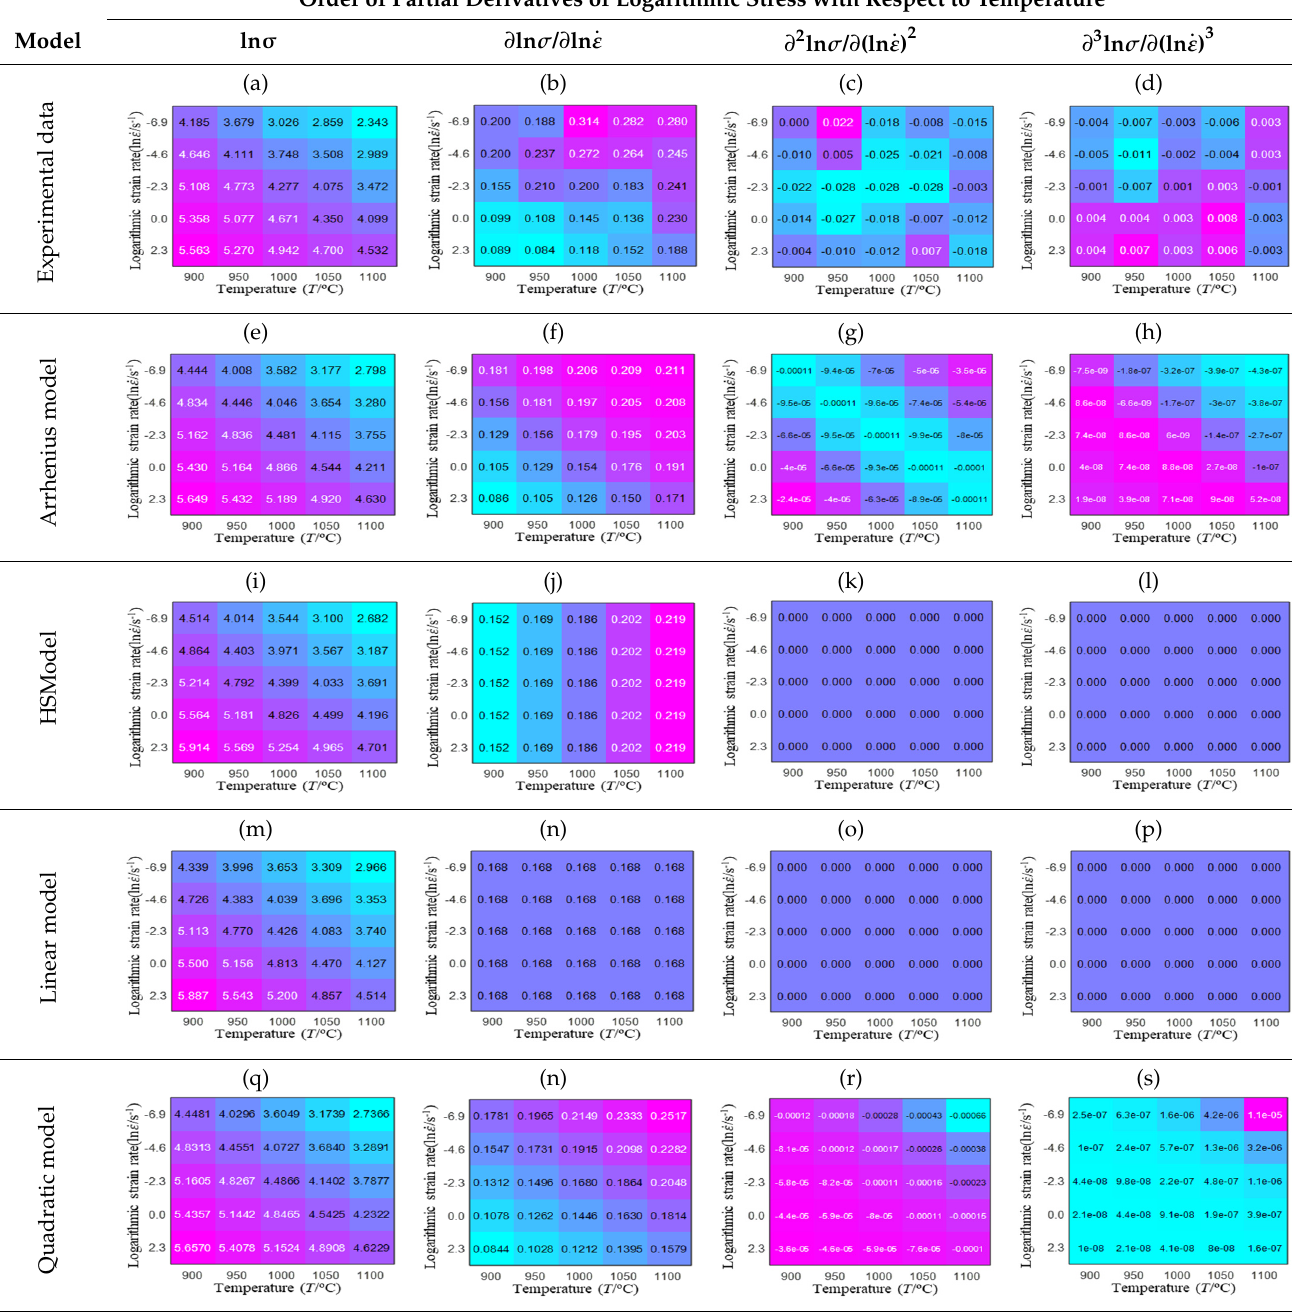
Table 9. The first, second and third partial derivatives of logarithmic stress with respect to strain rate Table 9. The fi rst, second and third partial derivatives of logarithmic stress with respect to strain Table 9. The fi rst, second and third partial derivatives of logarithmic stress with respect to strain Table 9. The fi rst, second and third partial derivatives of logarithmic stress with respect to strain Table 9. The fi rst, second and third partial derivatives of logarithmic stress with respect to strain Table 9. The fi rst, second and third partial derivatives of logarithmic stress with respect to strain Table 9. The fi rst, second and third partial derivatives of logarithmic stress with respect to strain Table 9. The fi rst, second and third partial derivatives of logarithmic stress with respect to strain for different models at ε = 0.04. Table 9. The fi rst, second and third partial derivatives of logarithmic stress with respect to strain Table 9. The fi rst, second and third partial derivatives of logarithmic stress with respect to strain Table 9. The fi rst, second and third partial derivatives of logarithmic stress with respect to strain Table 9. The fi rst, second and third partial derivatives of logarithmic stress with respect to strain Table 9. The fi rst, second and third partial derivatives of logarithmic stress with respect to strain Table 9. The fi rst, second and third partial derivatives of logarithmic stress with respect to strain Table 9. The fi rst, second and third partial derivatives of logarithmic stress with respect to strain Table 9. The fi rst, second and third partial derivatives of logarithmic stress with respect to strain Table 9. The fi rst, second and third partial derivatives of logarithmic stress with respect to strain Table 9. The fi rst, second and third partial derivatives of logarithmic stress with respect to strain Table 9. The fi rst, second and third partial derivatives of logarithmic stress with respect to strain Table 9. The fi rst, second and third partial derivatives of logarithmic stress with respect to strain Table 9. The fi rst, second and third partial derivatives of logarithmic stress with respect to strain rate for di ff erent models at 𝜀 = 0.04 . rate for di ff erent models at 𝜀 = 0.04 . rate for di ff erent models at 𝜀 = 0.04 . rate for di ff erent models at 𝜀 = 0.04 . rate for di ff erent models at 𝜀 = 0.04 . rate for di ff erent models at 𝜀 = 0.04 . rate for di ff erent models at 𝜀 = 0.04 . rate for di ff erent models at 𝜀 = 0.04 . rate for di ff erent models at 𝜀 = 0.04 . rate for di ff erent models at 𝜀 = 0.04 . rate for di ff erent models at 𝜀 = 0.04 . rate for di ff erent models at 𝜀 = 0.04 . rate for di ff erent models at 𝜀 = 0.04 . rate for di ff erent models at 𝜀 = 0.04 . rate for di ff erent models at 𝜀 = 0.04 . rate for di ff erent models at 𝜀 = 0.04 . rate for di ff erent models at 𝜀 = 0.04 . rate for di ff erent models at 𝜀 = 0.04 . rate for di ff erent models at 𝜀 = 0.04 . rate for di ff erent models at 𝜀 = 0.04 . . Order of Partial Derivatives of Logarithmic Stress with Respect to Temperature . Order of Partial Derivatives of Logarithmic Stress with Respect to Temperature . Order of Partial Derivatives of Logarithmic Stress with Respect to Temperature . Order of Partial Derivatives of Logarithmic Stress with Respect to . Order of Partial Derivatives of Logarithmic Stress with Respect to Temperature . Order of Partial Derivatives of Logarithmic Stress with Respect to Temperature